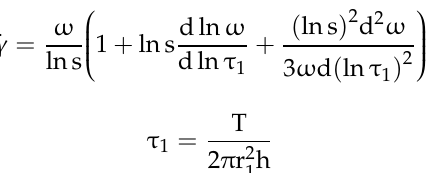
Figure 5. Average flow curve calculated for all measurements on cement paste.